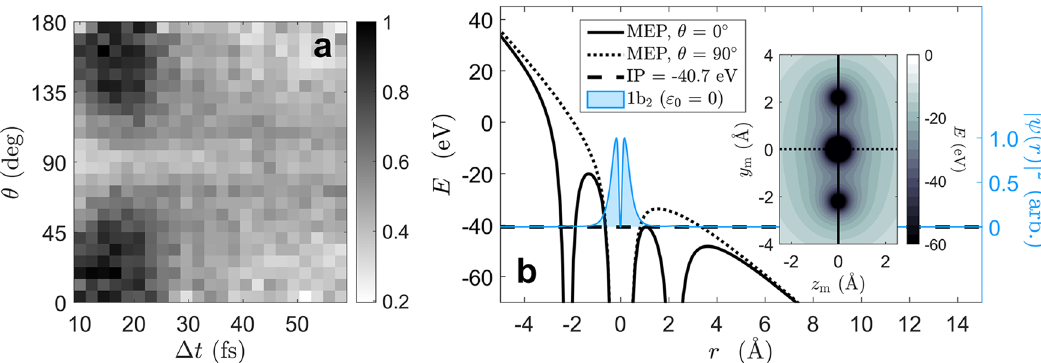
Fig. 5 A model of enhanced ionization for D 2 O 2 + → D 2 O 3 + . a The distribution of alignment angle θ ¼ arccos ð ^ y m (cid:2) ^ ϵ Þ for all D + /D + /O + coincidences as a function of interpulse delay ( Δ t ). b The simulated molecular electrostatic potential (MEP) of an unbent and stretched D 2 O 3 + ( r OD = 2.2 Å and θ = 180°) with a linearly polarized DC fi eld strength of 0.17 E ea θ = 0° (solid black line) and θ = 90° (dotted DOD h / 0 acting along two 1-dimensional cuts at black line). Also plotted is the simulated ionization potential (IP) of D 2 O 2 + (dashed black line) and the probability distribution ∣ ψ ( r ) ∣ 2 of the fi eld-free ( ε 0 = 0) 1b 2 molecular orbital in the ground state of D 2 O 2 + ( r OD = 2.2 Å and θ DOD = 180°). The inset to ( b ) displays a top-down view of the 2-dimensional fi eld-free MEP including lines to represent both 1-dimensional cuts: θ = 0° in solid cyan and θ = 90° in